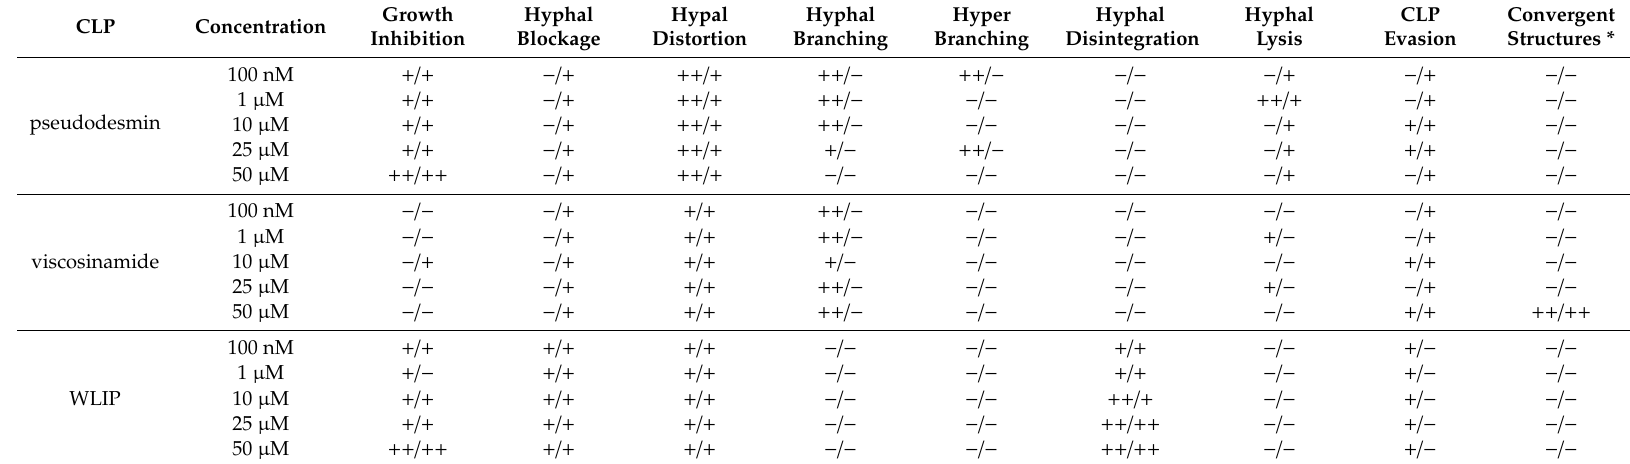
Table A2. Comparison between the e ff ects of pseudodesmin, viscosinamide and WLIP on P. myriotylum and R. solani